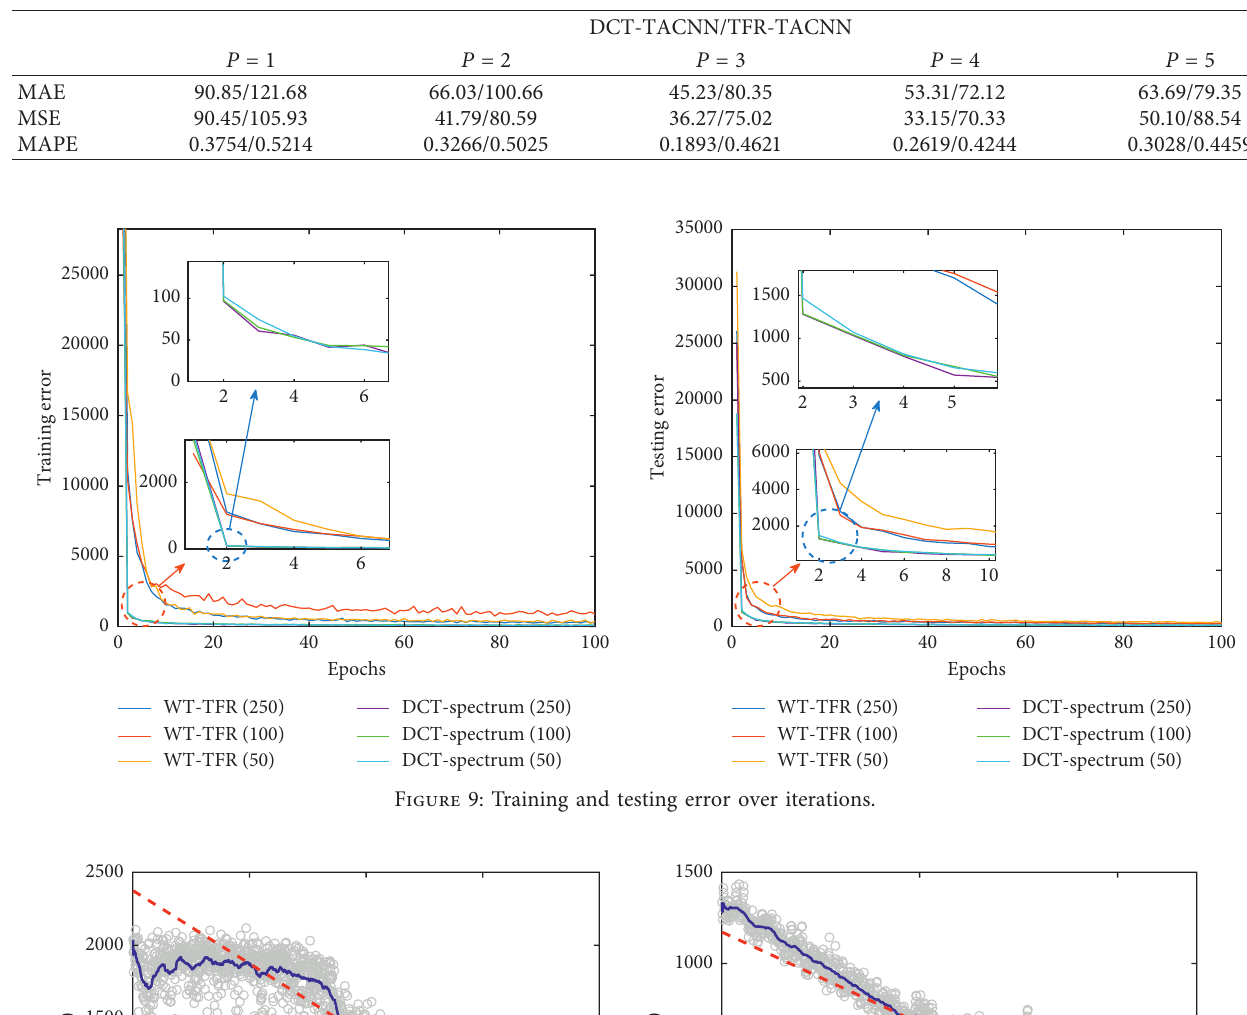
Table 3: Performance evaluation with different frame numbers.